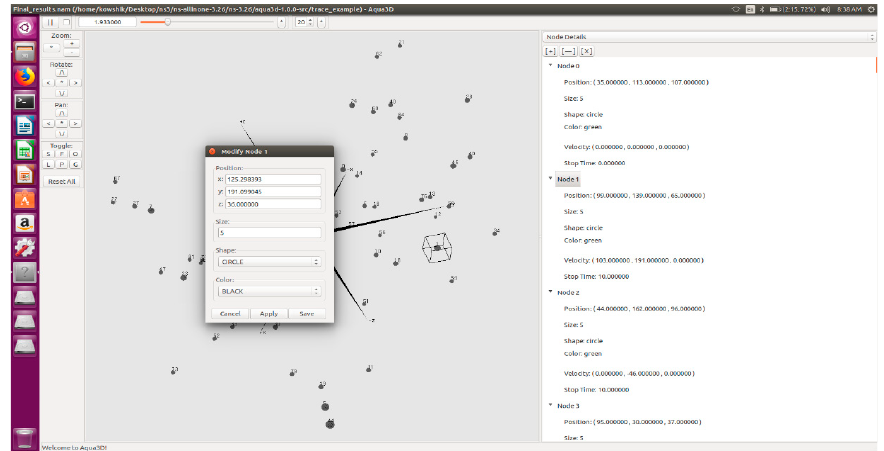
Figure 3. Node Coordinate values.